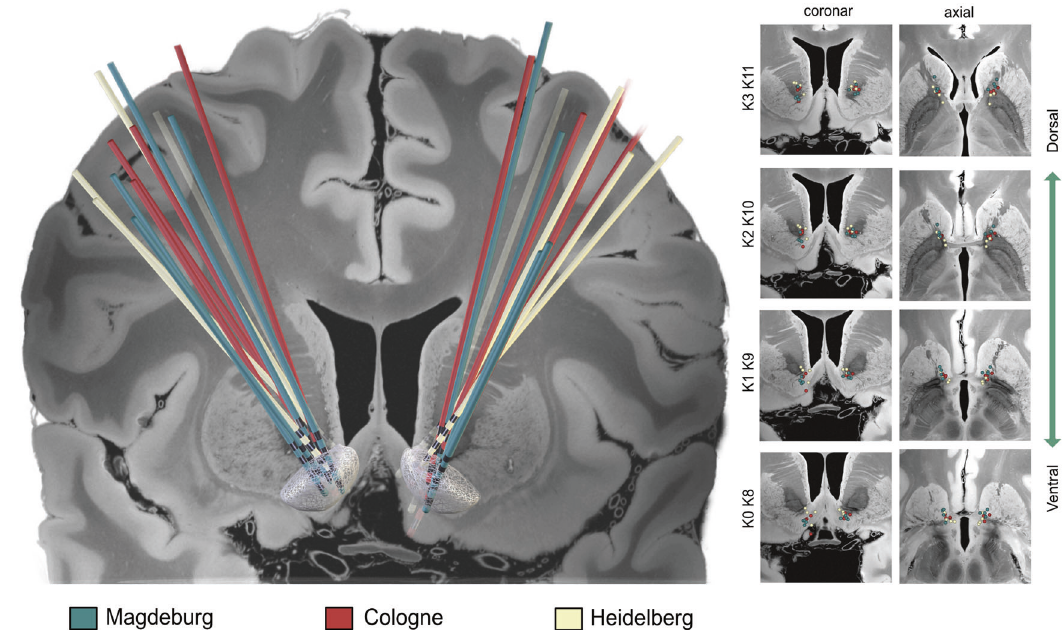
Fig. 2 Overview of electrode localization in standard space. All electrodes, colored by center, were reconstructed from preoperative magnetic resonance imaging and postoperative computer tomography, following the default pipeline of the LEAD-DBS software [75]. In the left image, the target area, i.e. the nucleus accumbens, is depicted as white mesh. The right image displays the projection on 2D slices for each contact level. All images are superimposed on slices of a 7 Tesla brain scan in MNI space